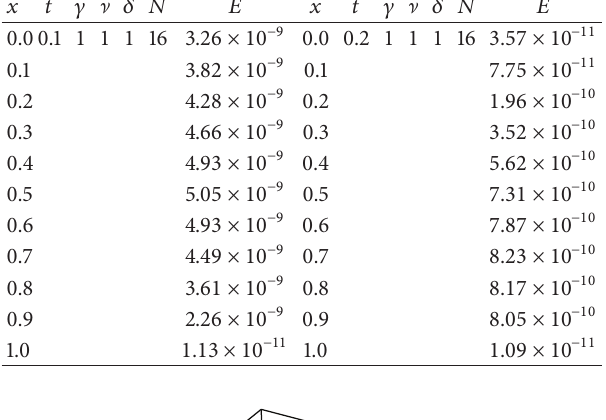
Table 8: Absolute errors with 𝛼 = 𝛽 = 0 , 𝛿 = 1 and various choices of 𝑥, 𝑡 for Example 3.